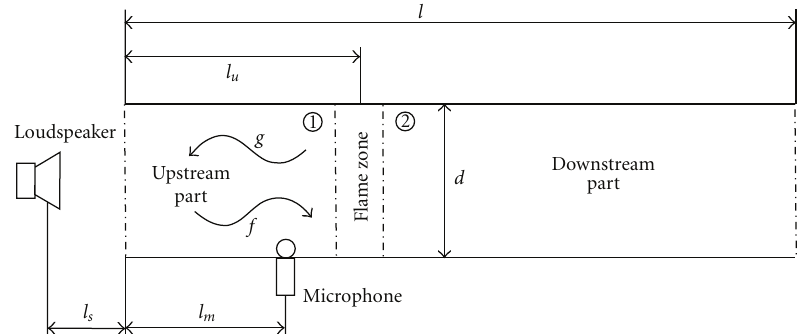
Figure 2: Schematic drawing of the Rijke tube setup.